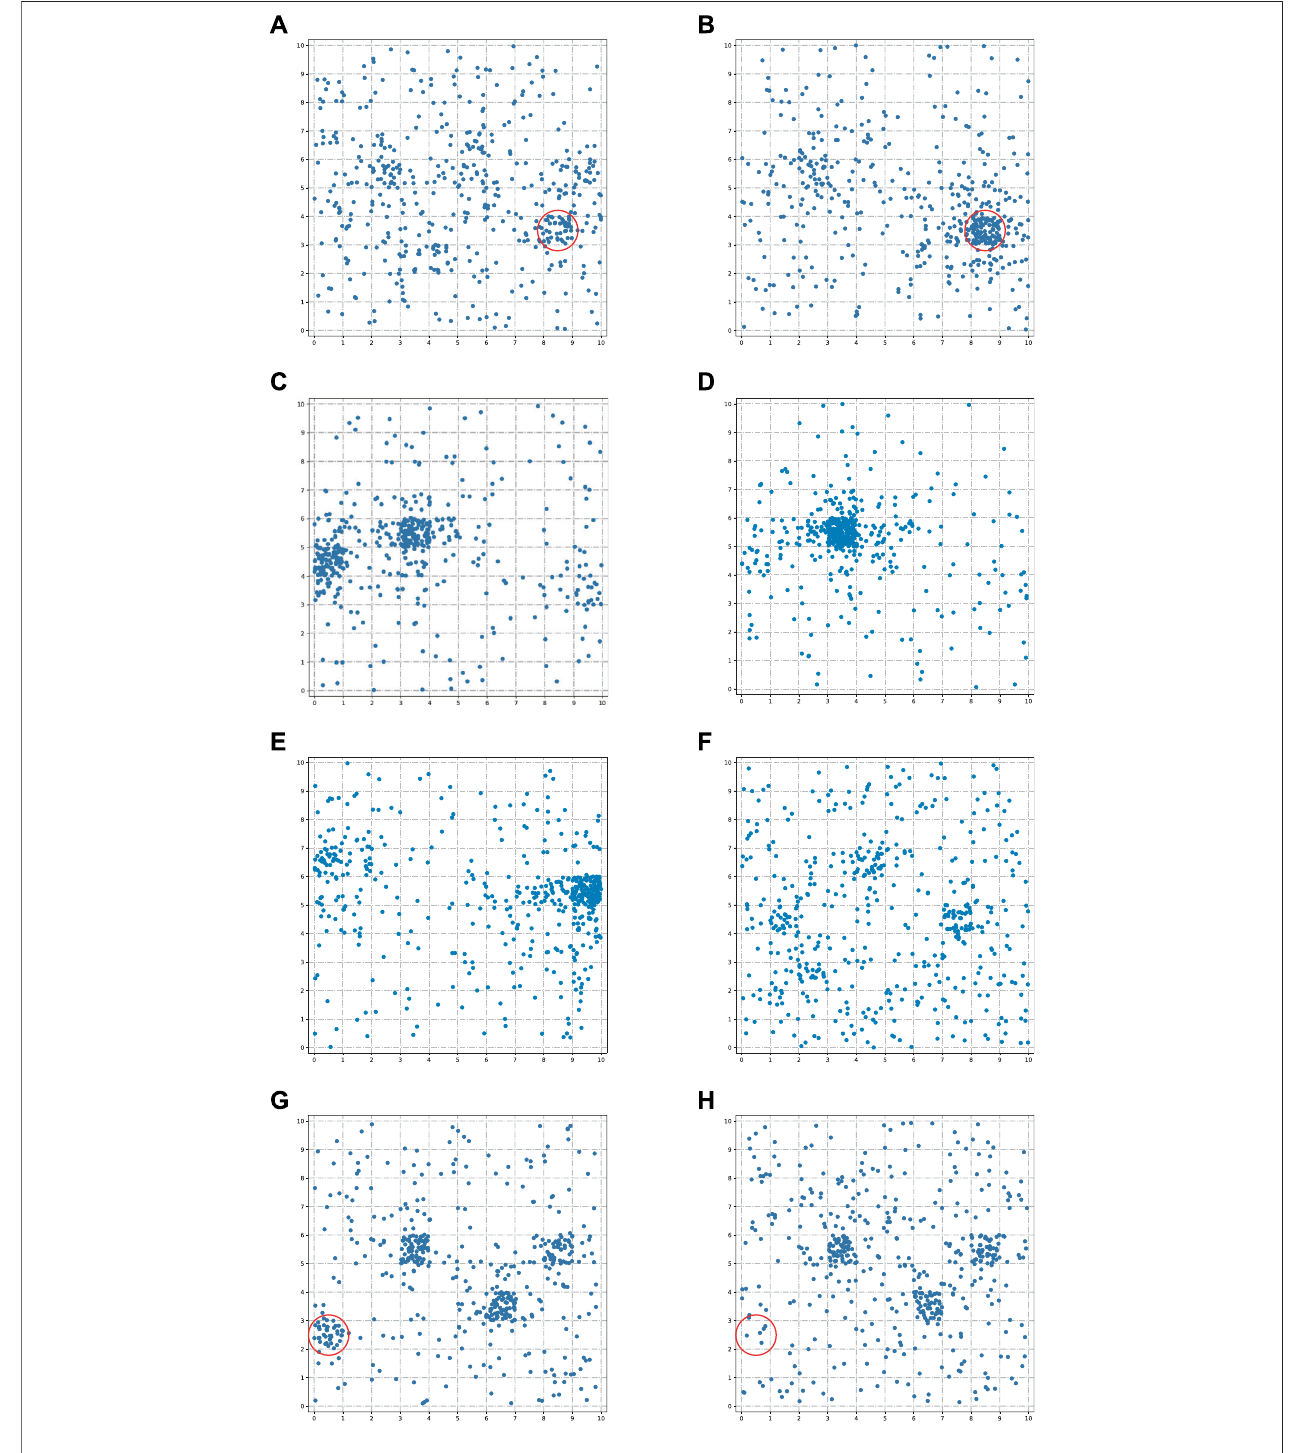
FIGURE 7 | Evolutionary behaviors of communities. (A,B) presents community growth behavior, (C,D) presents community fusion behavior, (E,F) presents community split behavior, and (G,H) presents community disappear behavior.